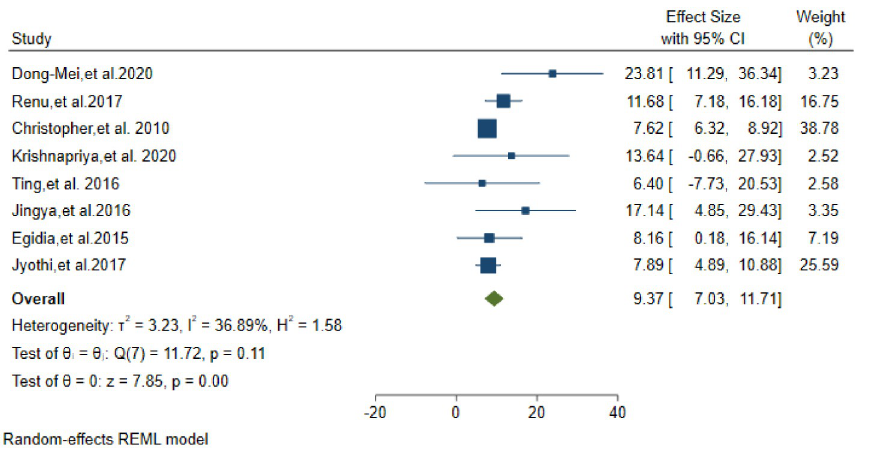
Fig 5. Prevalence of INH mono resistance in Tuberculosis meningitis confirmed isolates.